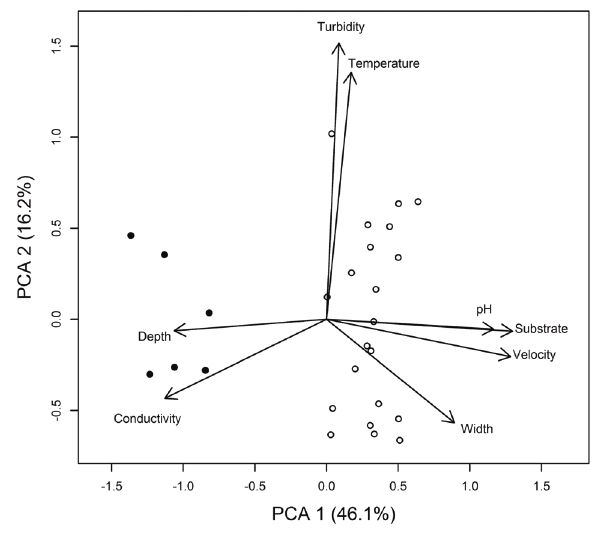
Fig. 2. Results of the Principal Component Analysis (PCA) showing the clearwater (open circles) and blackwater (black circles)